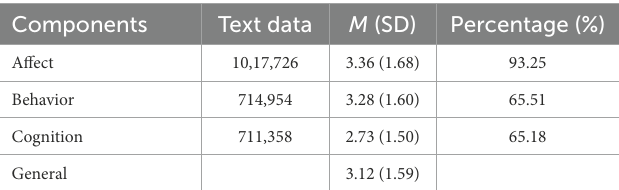
TABLE 2 The overall findings on four attitudinal aspects of Weibo users toward IWLG across 31 provinces.